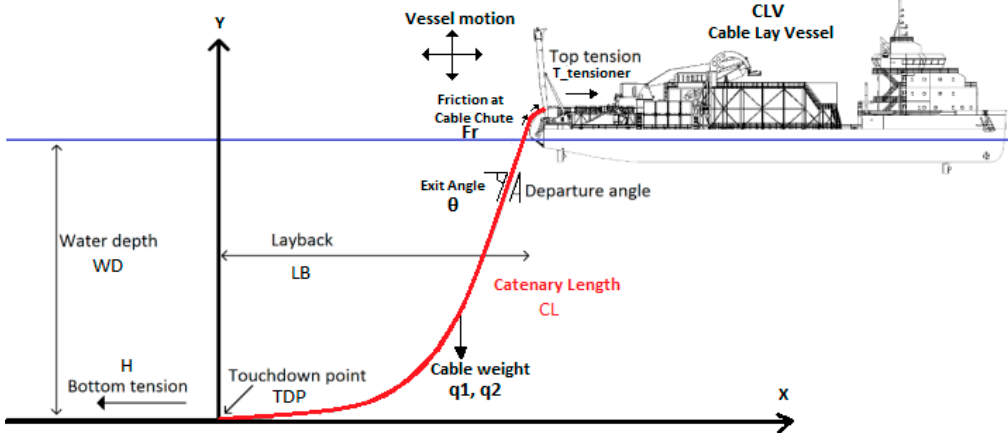
Figure 1. Demonstration of the most influential parameters during a cable S-lay installation.